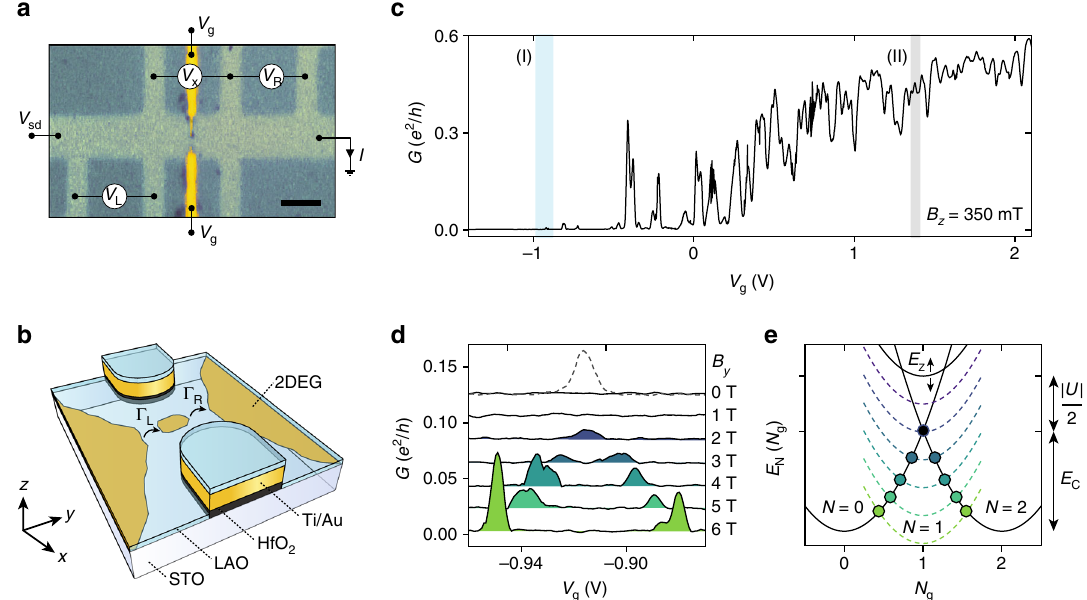
Fig. 1 Device and zero-bias transport characteristics. a Optical microscope image of the split-gate device. The dark color shows the LSM hard mask and the STO is exposed to the LAO at the light colored regions forming a two-dimensional electron gas (2DEG). Scale bar is 5 μ m. The 200 nm wide metal top gates are 1 μ m apart. b Schematic of the device and formation of the QD close to pinch off with tunnel couplings Γ L,R to the 2DEG. c Conductance as a function of V g showing depletion for V g < − 1 V. The two regions I and II, of weak and strong tunnel coupling, respectively, are investigated in detail. d Conductance G ( V g ) for V sd = 0 in region I with varying magnetic fi eld B y = 0 to 6 T ( solid lines ). For clarity, traces are vertically offset by ~0.012 e 2 /h. For B = 0 a single peak is observed when increasing the bias to V sd = 160 μ eV ( dashed ). e Dependence of the ground-state energy on gate-induced charge N g = C g V g /2 e for a single orbital with occupation N = 0,1,2 and effective negative charging energy U . Solid lines represents B y = 0 and dashed lines illustrate the Zeeman splitting of the odd- N state at B y = 1 – 6 T. For E Z ≥ | U | , sequential single electron transport is allowed at the points marked with